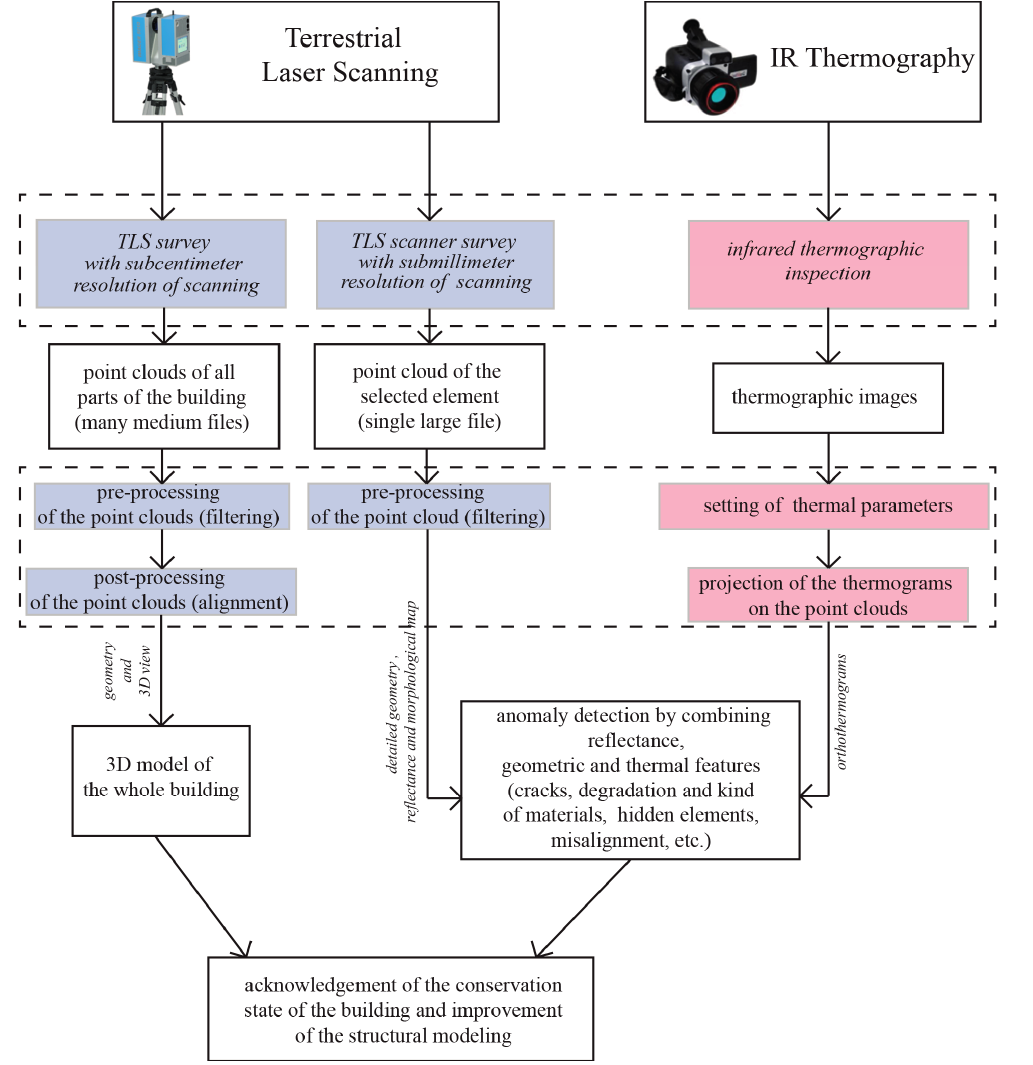
Figure 2. Scheme of the methodology used to integrate the results of TLS and IR